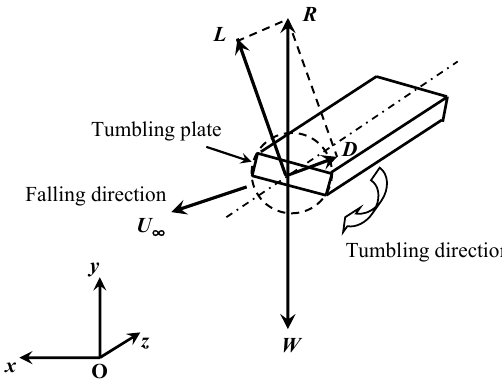
Fig. 2 Schematic diagram of the tumbling rectangular plate and